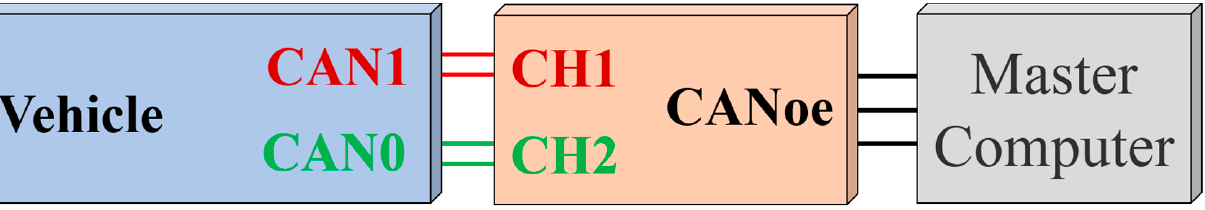
Figure 6. Structure diagram of the test program.(CAN0, CAN1, CH1 and CH2 are the interface of CAN).